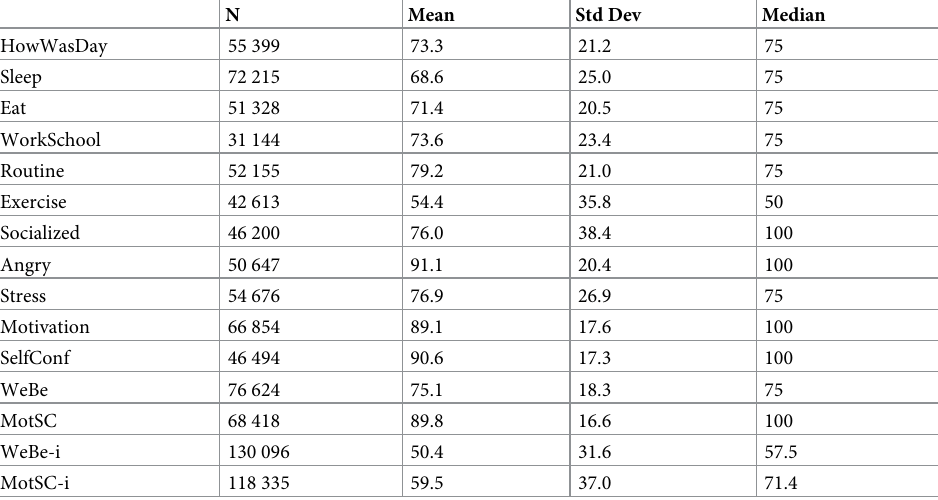
Table 2. Summary of the questionnaire data (row 1–11), average data (12–13) and the imputed digital biomarkers (14–15). The imputation increases the number of days (N) with available data with a factor of ~2.